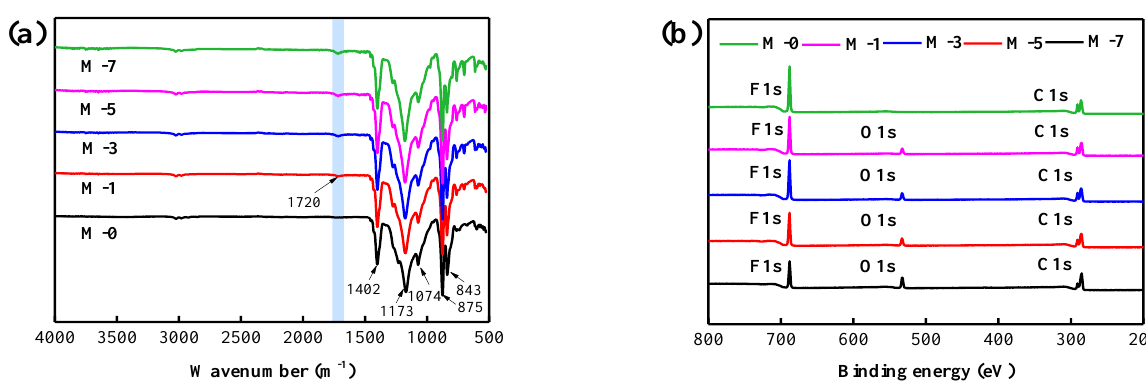
Figure 2. ( a ) ATR − FT − IR spectra of membranes, ( b ) XPS spectra of membranes. The chemical elements on the membrane surface were investigated via XPS measure- ments, indicated in Figure 2b. In the XPS of the M-0 membrane, the peaks with binding energy values of 285.1 and 688.1 eV were generated by C1s and F1s, respectively, while for the F127@SMA/PVDF membranes, new peaks with a binding energy of 533.1 eV were observed. These new peaks were attributed to O1s from the F127@SMA polymers. To facilitate observation of the elemental changes on the membrane surface, the content of the elements and the ratio of O and F are presented in Table 1. From M-0 to M-7, with the increase of F127@SMA content, the O/F ratio gradually increased. It was noteworthy that M-7 exhibited the lowest content of the F element (13.8%) and the highest content of the O element (18.1%). From these results, it can be concluded that the F127@SMA was successfully blended into the PVDF matrix. Table 1. Elemental composition of membranes determined by XPS.